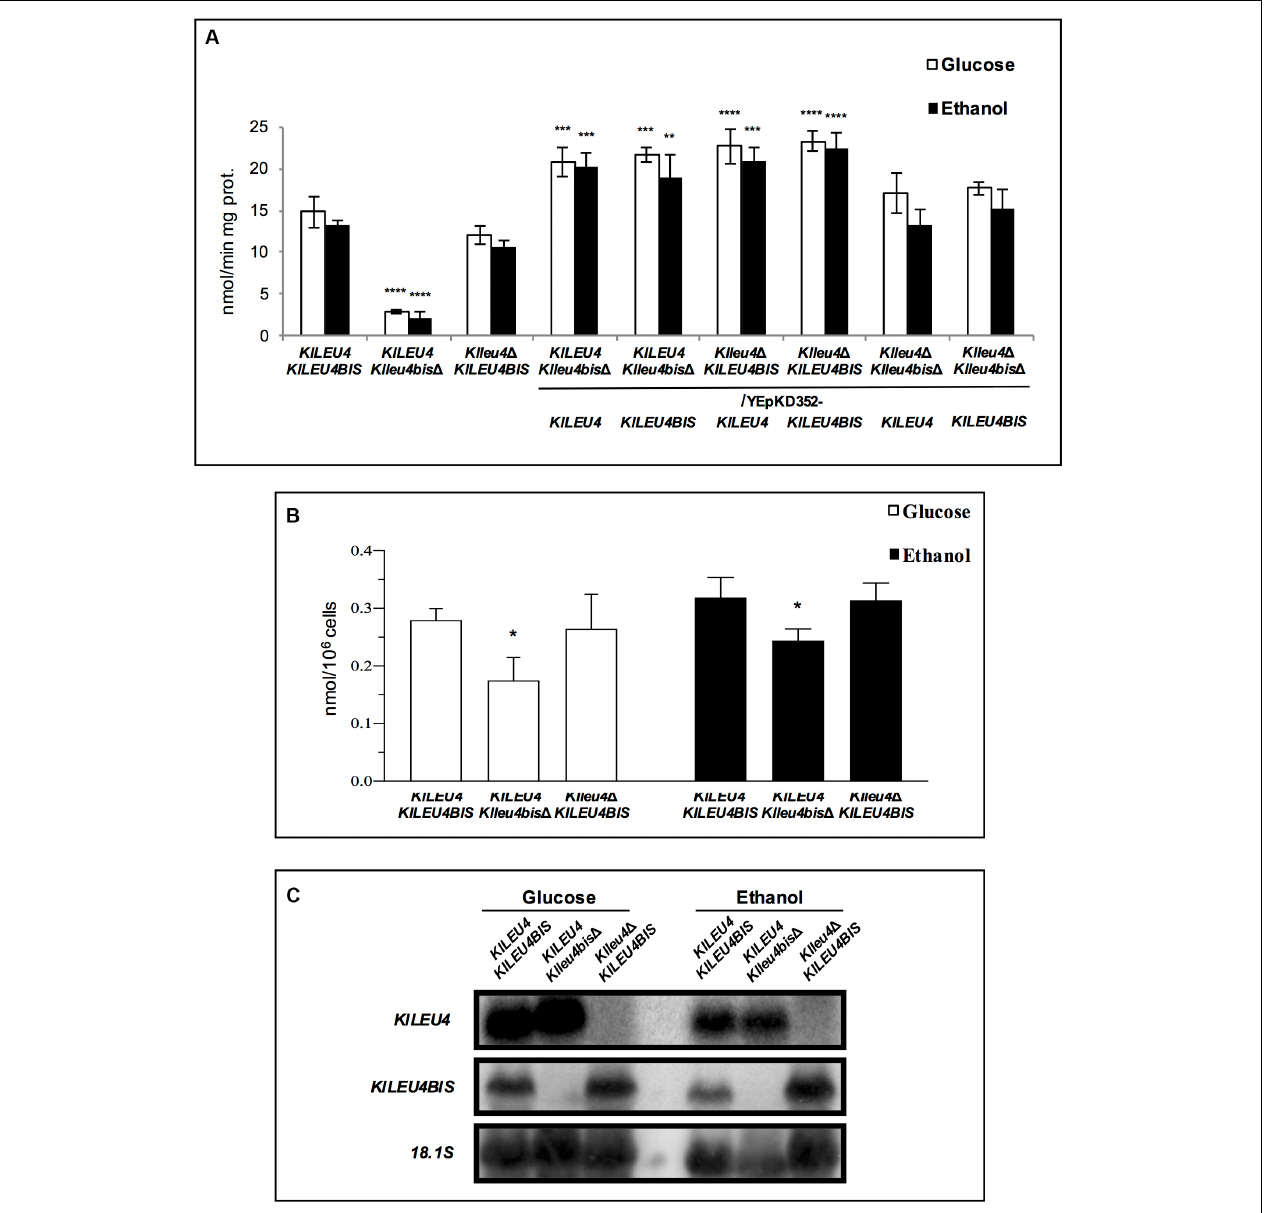
FIGURE 4 | α -IPMS activity, leucine pools and expression profiles determined in extracts obtained from cultures of K. lactis mutant strains. (A) Enzymatic activity of derived single and double Klleu4 (cid:49) and Klleu4bis (cid:49) mutants transformed with KlLEU4 or KlLEU4BIS. Wild type KlLEU4 KlLEU4BIS and derived single KlLEU4 and KlLEU4BIS mutants were used as control. Extracts were prepared from cells grown on minimal medium with either 2% w/v glucose or 2% v/v ethanol as sole carbon sources. (B) Leucine pools of wild type KlLEU4 KlLEU4BIS and derived single Klleu4 (cid:49) and Klleu4bis (cid:49) mutants were prepared as described in section “Materials and Methods.” In (A,B) , bars indicate mean ± SD ( n = 3), * p < 0.05, ** p < 0.01, *** p < 0.001, *** p < 0.0001. (C) Northern analysis was carried out as described in section “Materials and Methods.” Total Yeast RNA was prepared from 100 mL aliquots of cultures grown to an OD 600 nm ∼ 0.6 on minimal media with 2% w/v glucose or 2% v/v ethanol as carbon sources. Specific probes are described in section “Materials and Methods.” Blots were scanned using the program ImageQuant 5.2 (Molecular